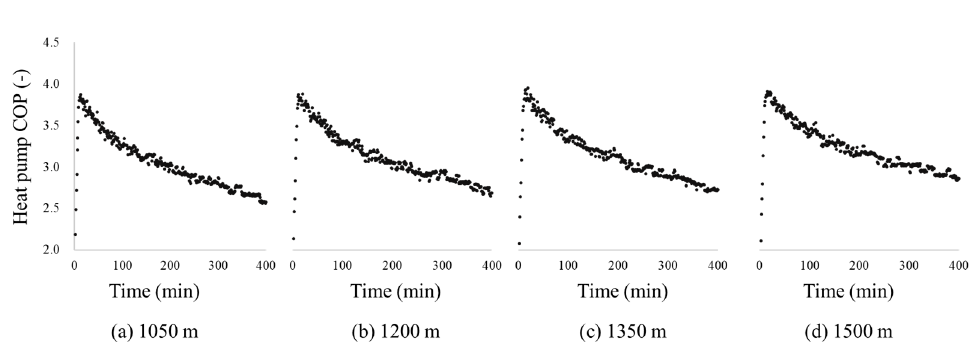
Figure 15. Heat pump COP change according to the GHEX length. ( a )1050 m; ( b )1200 m; ( c ) 1350 m; ( d ) 1500 m. ( d ) 1500m.